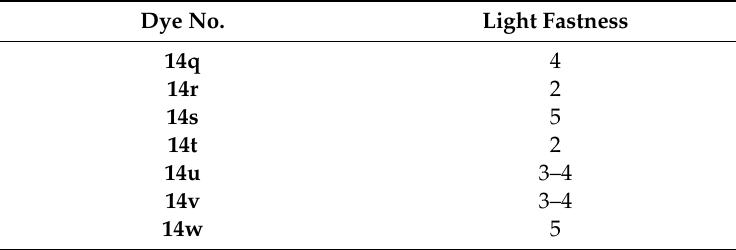
Table 2. Light fastness of azo